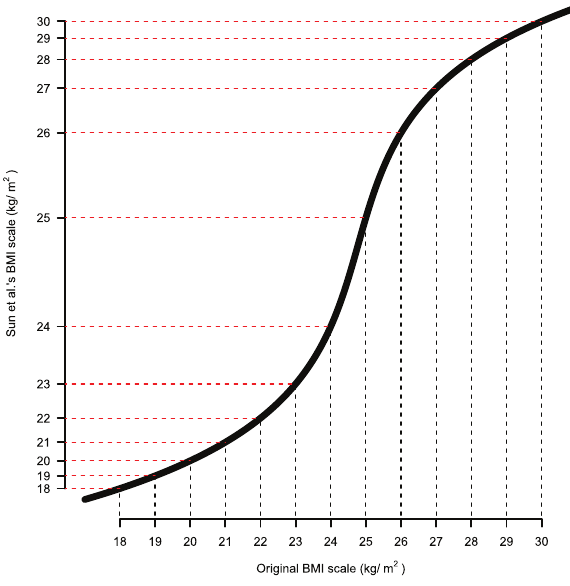
Figure 1. Comparison of the original scale of body mass index (BMI) and the transformed scale using Sun et al. ’s 1 transformation. The transformation was determined by the phenotypic distribution across FTO genotypes reported by Yang et al. 2